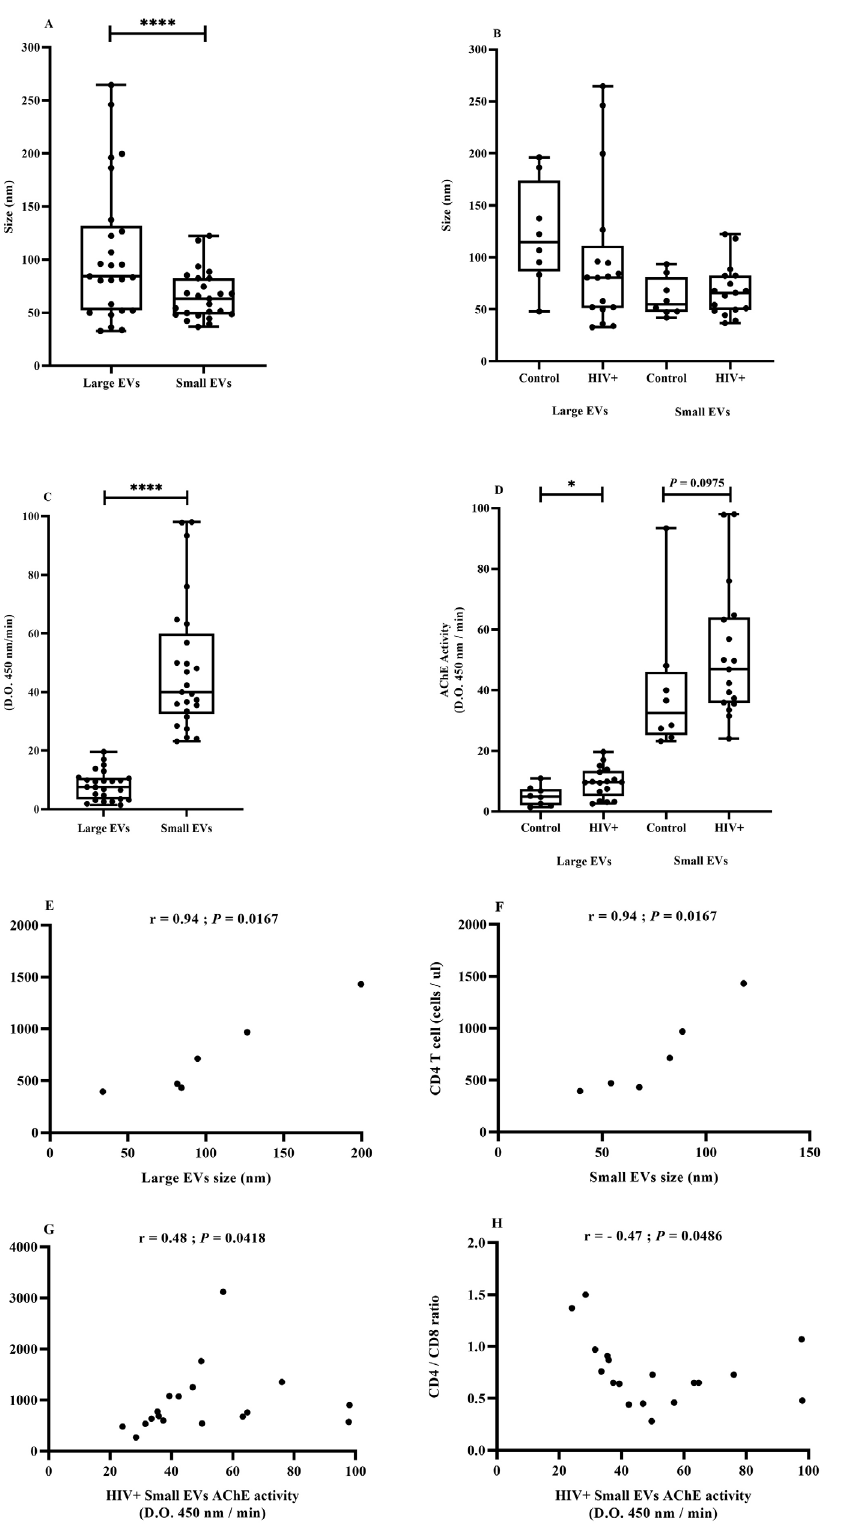
Figure 1. EV size and AChE activity in association with HIV. The cohort included uninfected participants (control, n = 8), patients infected with HIV (HIV+) but not treated (naive, n = 6), and patients treated successfully with antiretroviral therapy (ART, n = 11). Large and small EVs were purified as described in the Methods section. EV size distribution (Figure 1A and B) and EV AChE activity (Figure 1C and D) were evaluated respectively by dynamic light scattering and ELISA. Correlation between CD4+ T-cell count and large (Figure 1) or small (Figure 1) EV size. Correlation of CD8+ T-cell count (Figure 1G) or CD4/ CD8 ratio (Figure 1H) with small EV AChE activity. Asterisks denote a significant difference ( P ≤ 0.05) based on Wilcoxon matched-pairs signed- rank